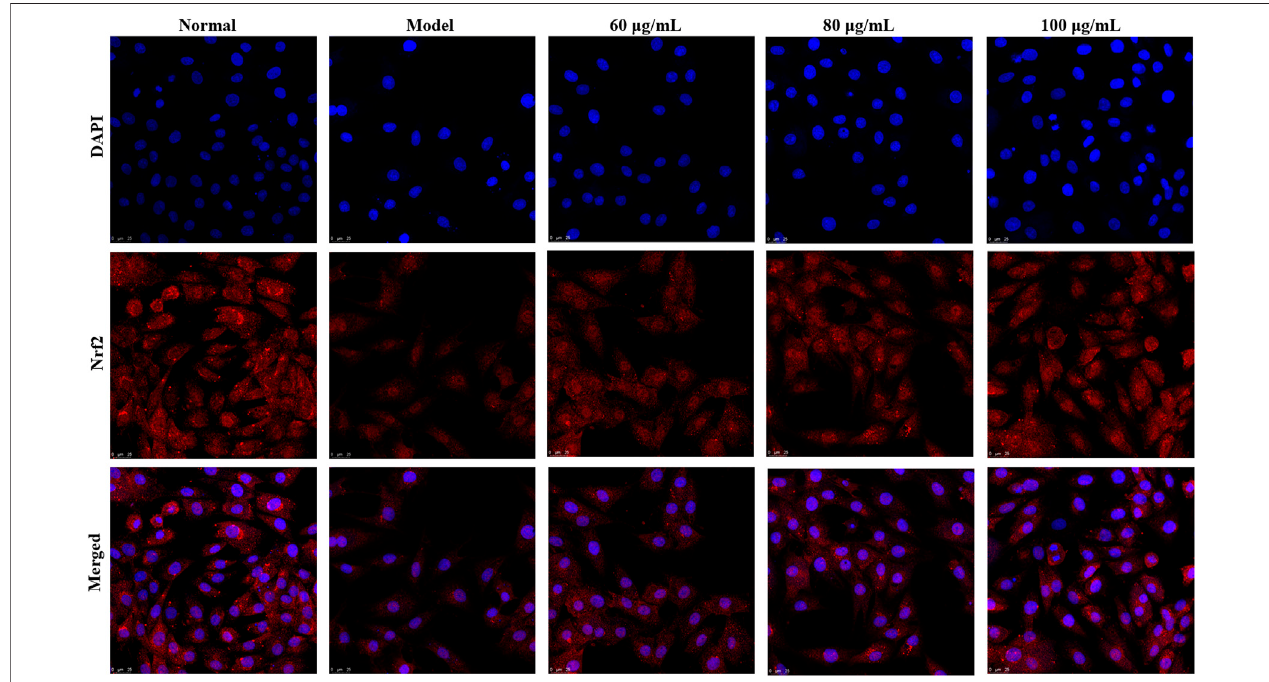
FIGURE 11 | Effects of YTC on nuclear transcription of Nrf2 in H 2 O 2 -induced H9c2 cells. H9c2 cells were treated with YTC (60, 80 and 100 μ g/ml) for 24 h, subsequently subjected to H 2 O 2 (200 μ M) for 4 h. The nuclear transcription of Nrf2 was determined by laser confocal